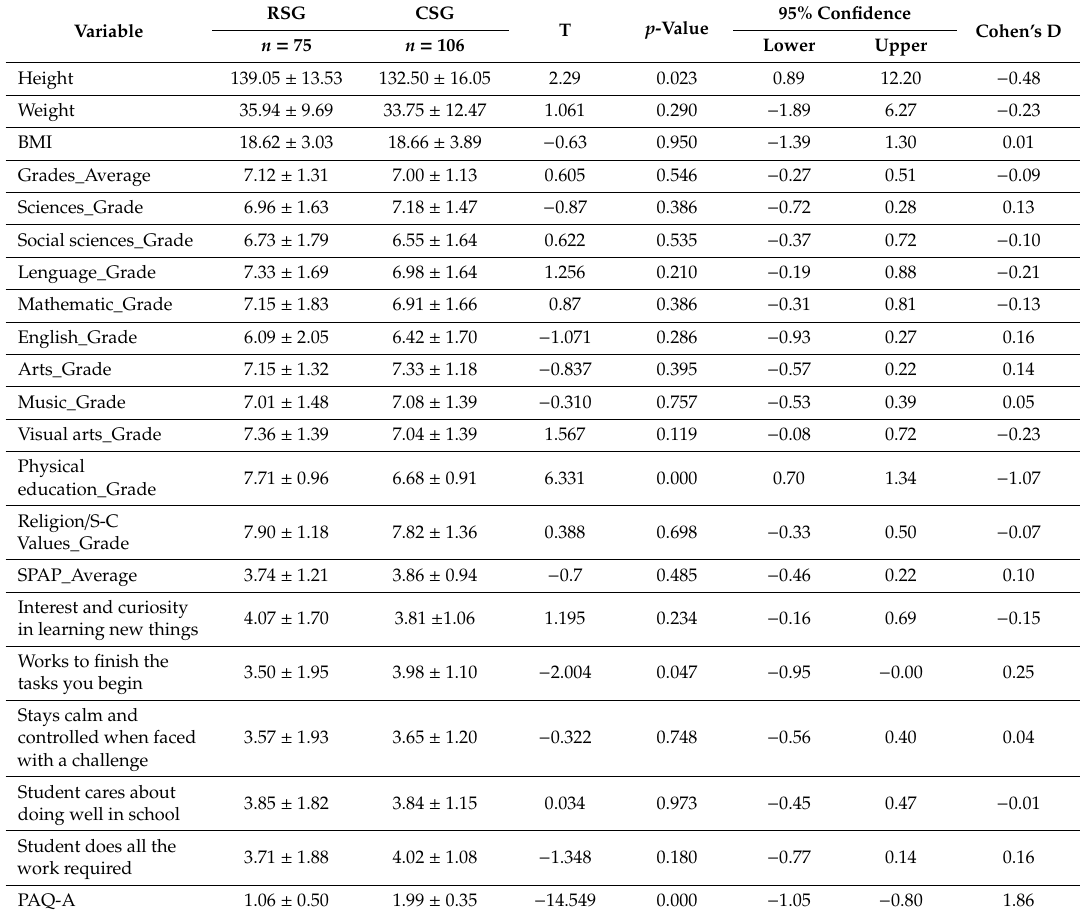
Table 2. Body composition, academic performance and physical activity habits of rural and city school